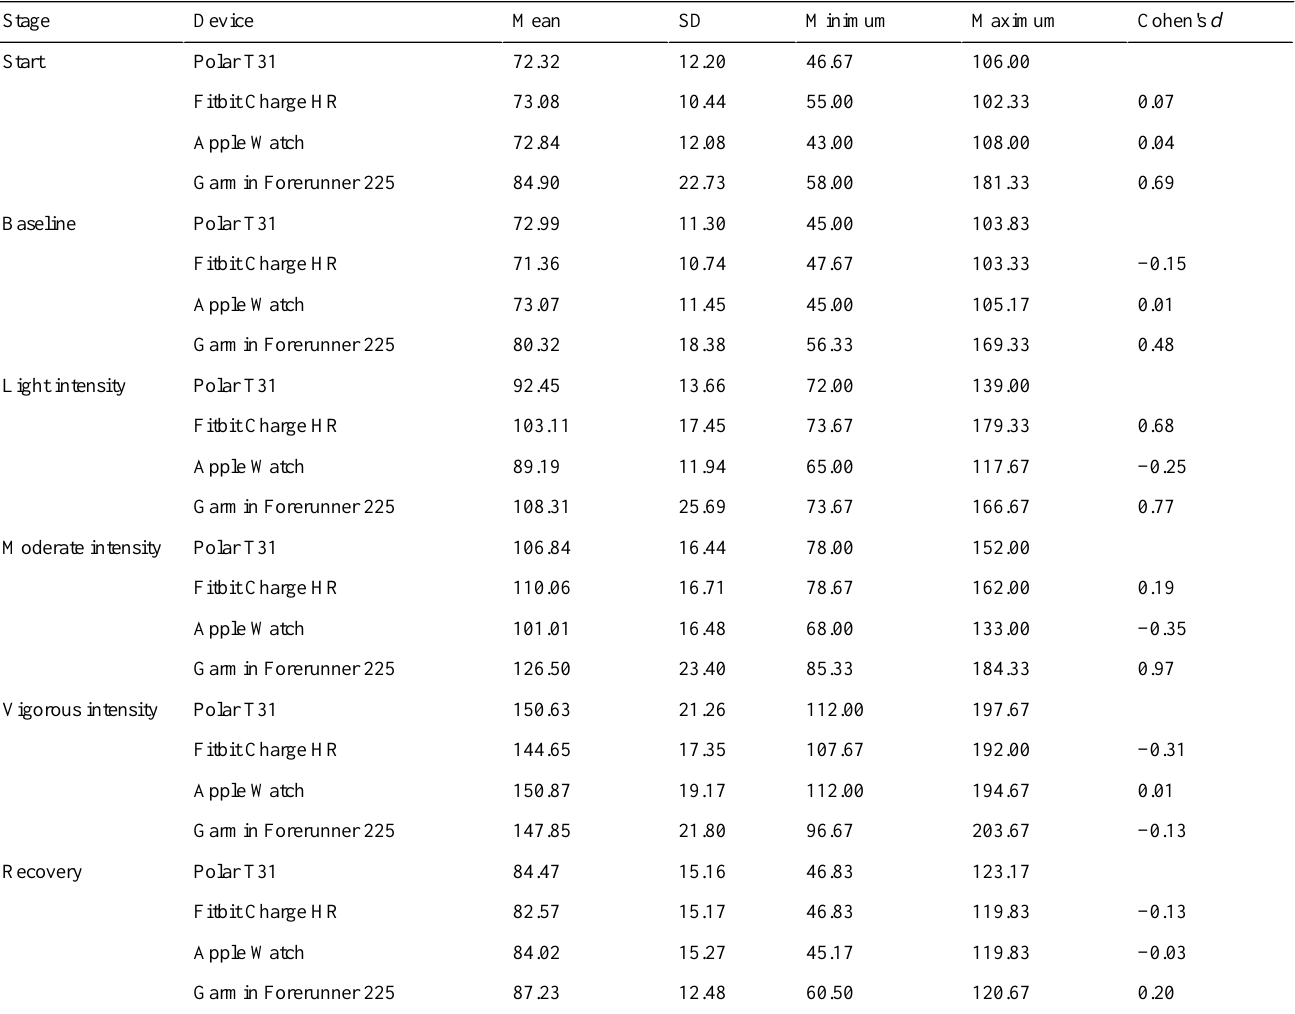
Table 2. Average heart rate (beats per minute) by exercise intensity per